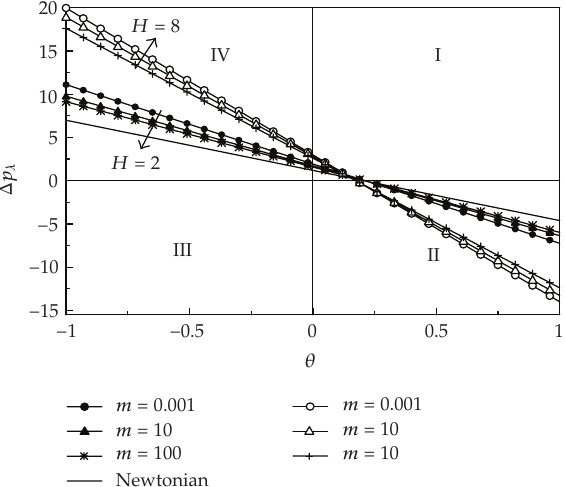
Figure 2: The pressure rise versus flow rate for α (cid:8) 0 . 4 , N (cid:8) 0 . 4 , H (cid:8) 2, and H (cid:8) 8 at di ff erent values of m